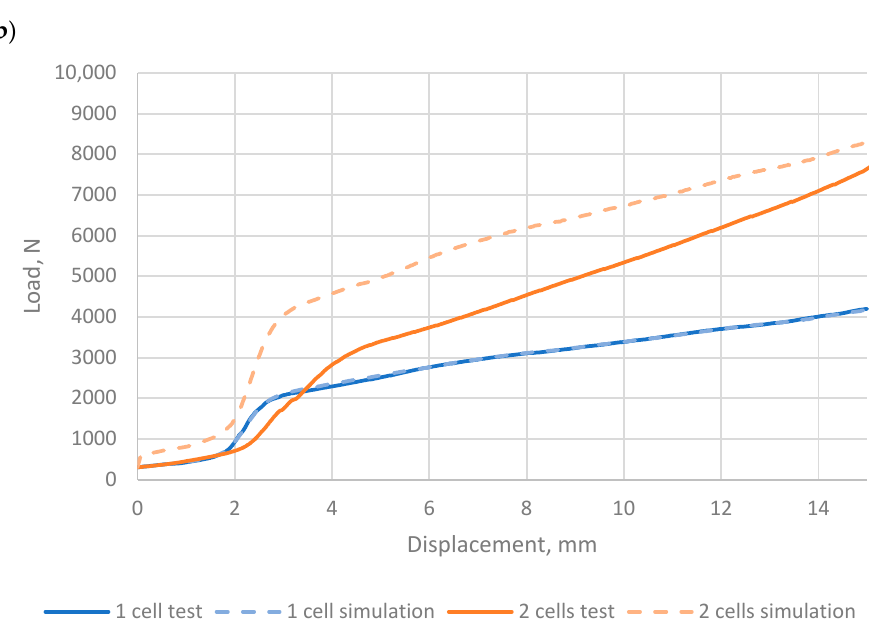
Figure 10. Comparison between the simulation and physical confined compression test data for ( a ) single and double cells compressed along the X axis and ( b ) single and double cells compressed along the Y